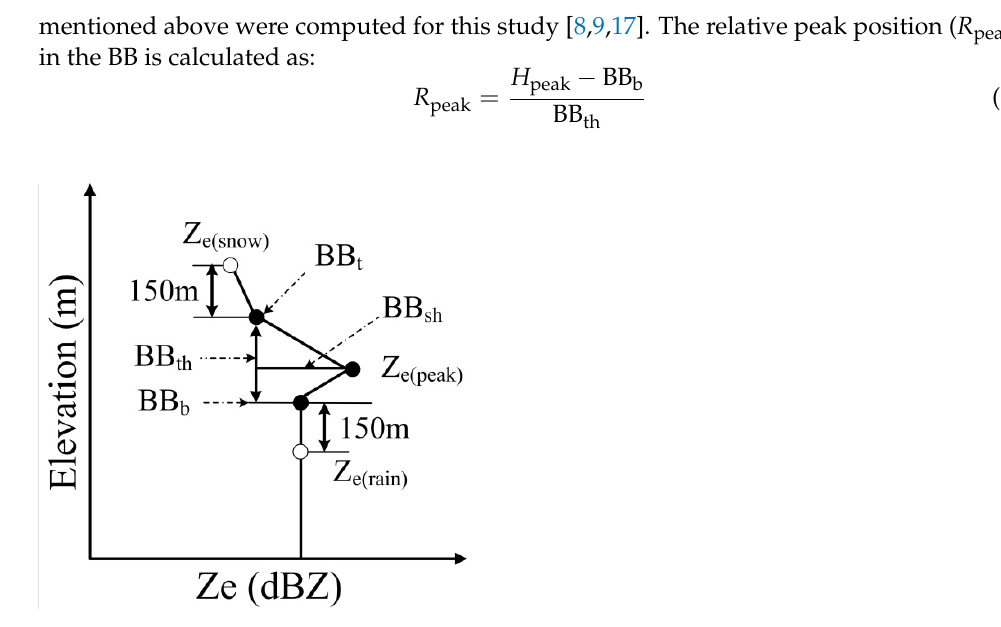
Figure 3. Schematic illustration of all types of parameters derived from the MRR reflectivity obser- vation data. (BB t and BB b are the top and bottom of the BB, BB th is the thickness of BB, Z e( peak) is the peak reflectivity in BB, H peak is the height of peak reflectivity in BB, R peak is the relative position of the H peak in BB, Z e (snow) is defined as the reflectivity 150 m above the BB t , the reflectivity of rain Z e (rain) is measured 150 m below the bottom height BB b .).